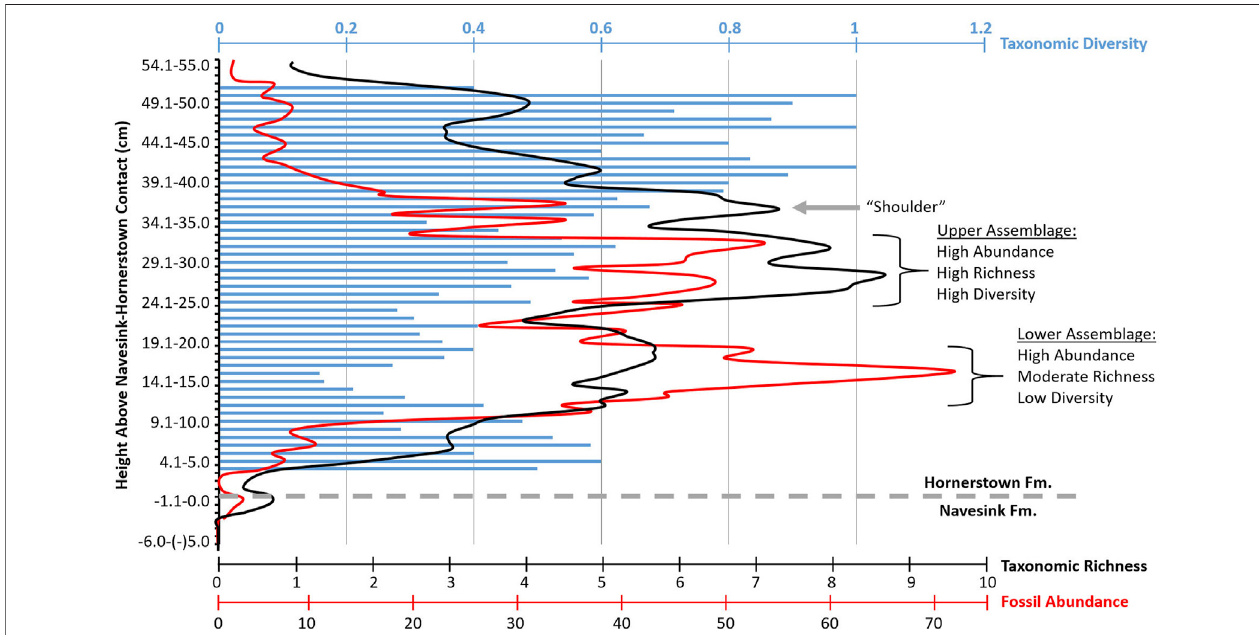
FIGURE3| Summaryoffossilabundances,SimpsonDiversityIndices,andtaxonomicrichnessper1 cmbinsinourexcavationarea.Taxonomicdiversityvalues( (cid:1) Simpson Diversity Indices) are shown as blue bars. Taxonomic richness and fossil abundance counts are each summarized by three-point running average curves, shown as the black and red lines, respectively. The stratigraphic interval encompassed by each fossil assemblage and the “ shoulder ” of the MFL (described in the text) are labeled, along with compositional characteristics of each fossil assemblage.